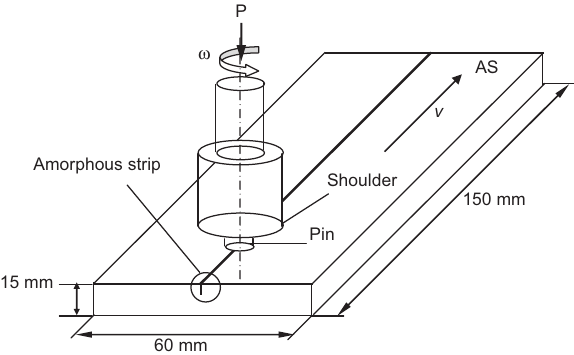
Figure 1 The schematic of FSP.